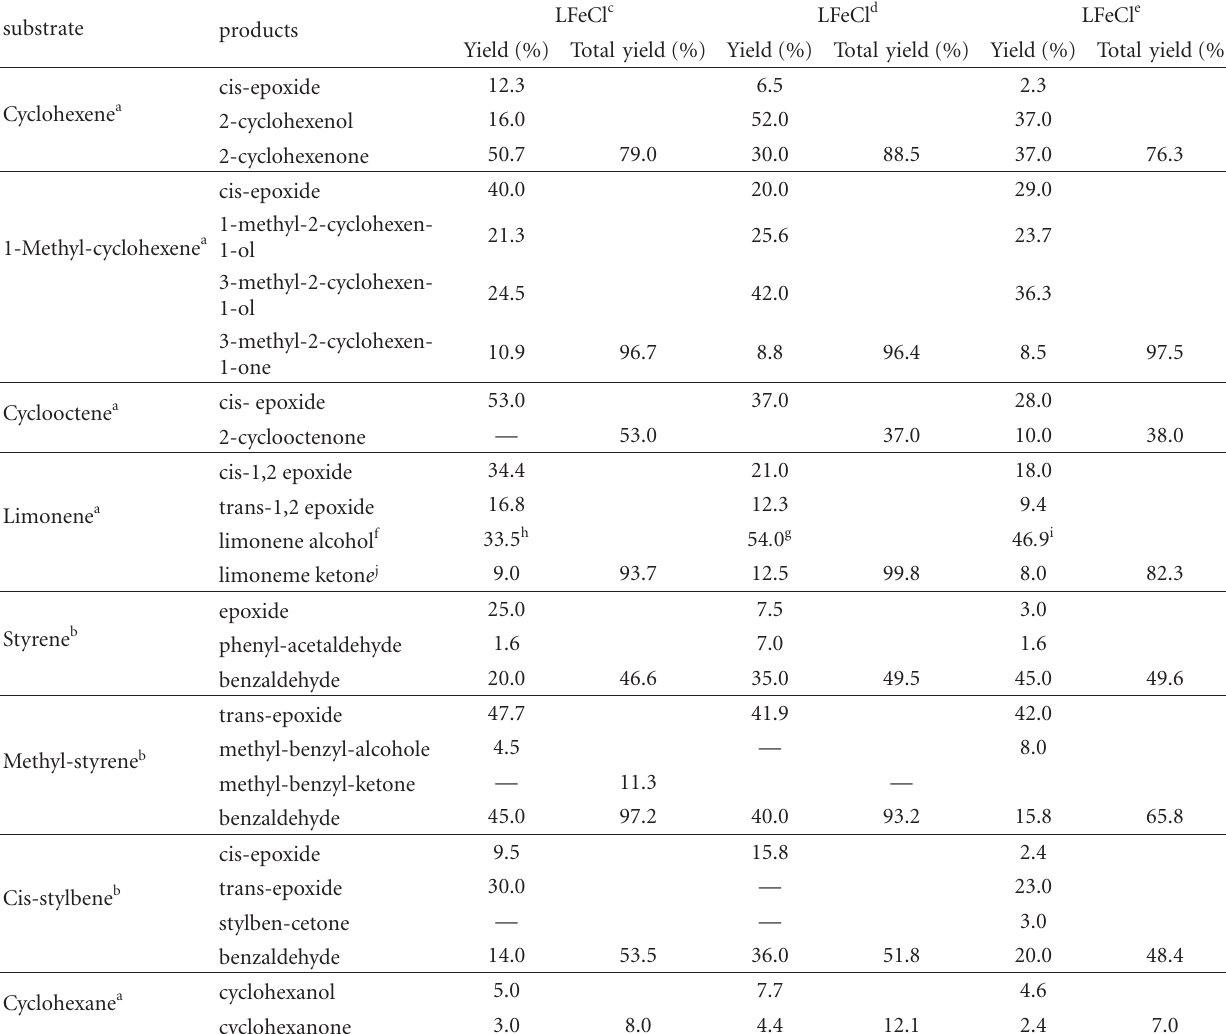
Table 2: Hydrocarbon oxidation by L Fe III Cl